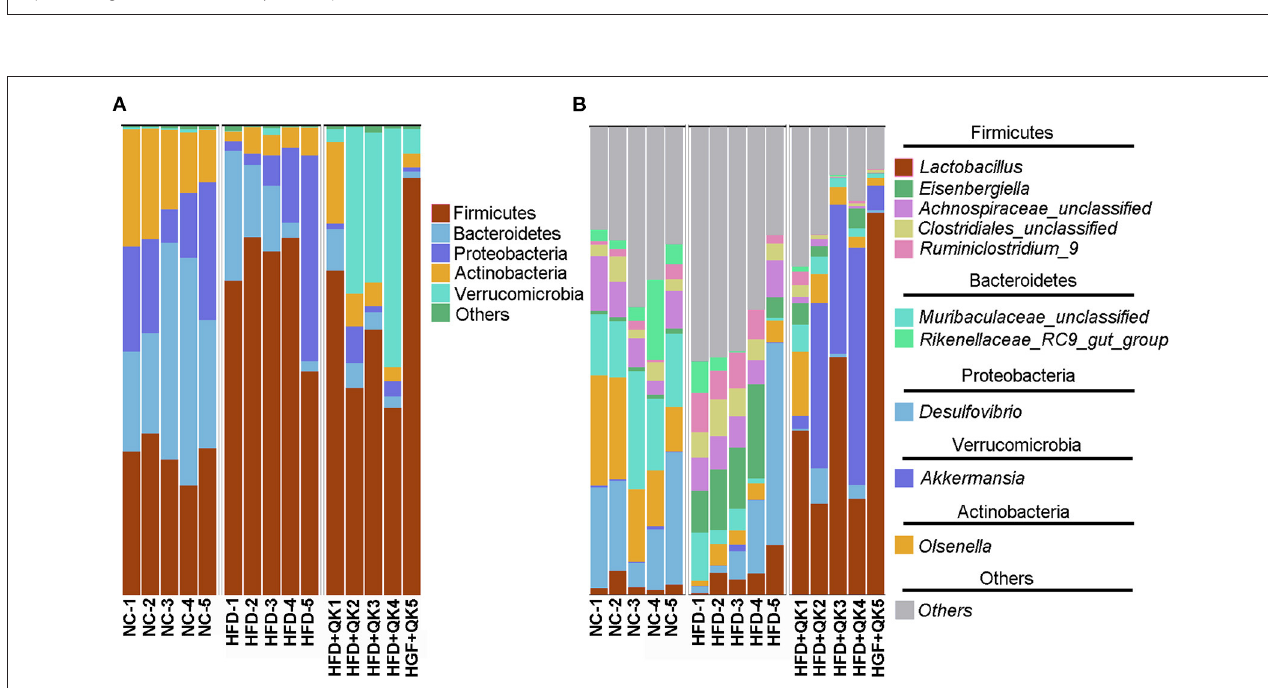
FIGURE 4 | Effects of WGQK on gut microbiota composition in mice. (A) Phylum-level gut microbiota composition in the three mice groups. According to the relative abundance, the top 5 phyla labeled with their taxonomic names are shown. (B) Genus-level gut microbiota composition. Top 10 genera in the three mice groups are